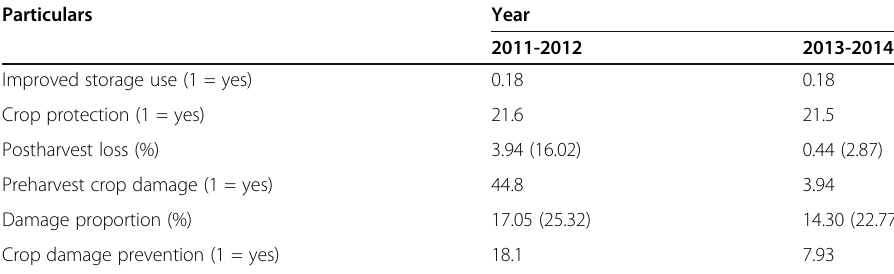
Table 3 Pre and postharvest maize loss and storage methods